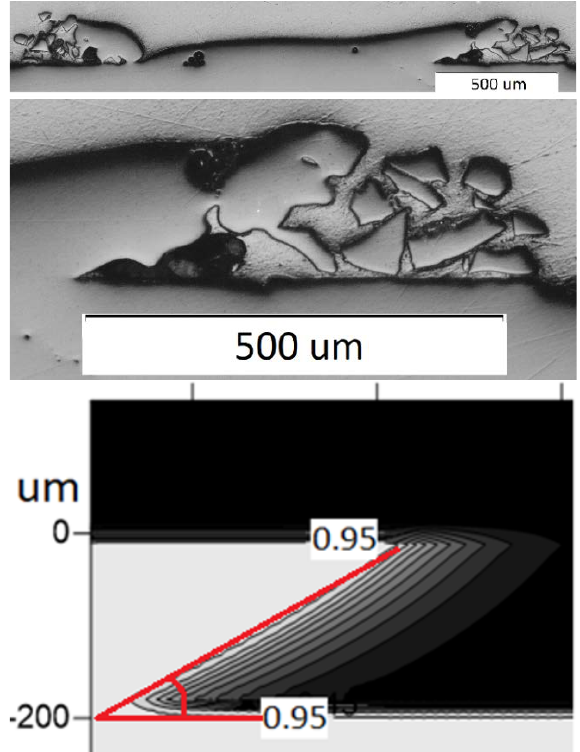
Fig. 8. Cross section of tracks made at 1 mm/s 20 W(on the top) same zoomed track (in the middle) and the modelling (on the bottom). The red lines show the angle between the substrate and the consolidation border.